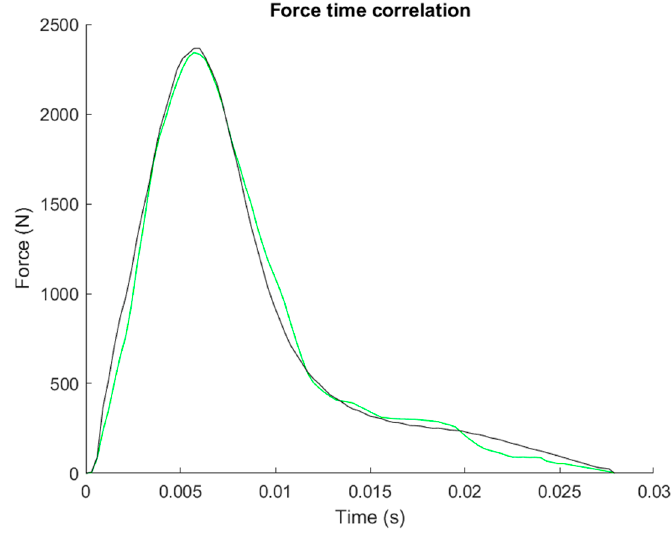
Figure 5. Force ‐ time progression sensor (green) vs. Kistler force plate (black) . Figure 5. Force-time progression sensor (green) vs. Kistler force plate